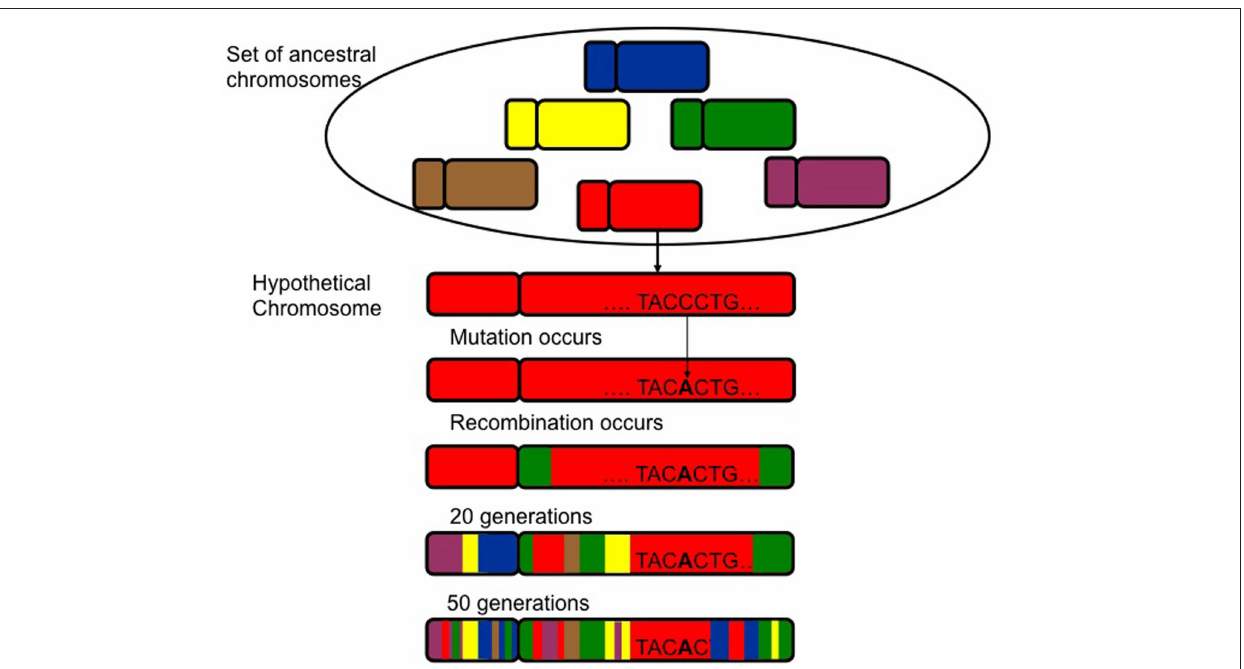
Figure 2 | The preservation of linkage disequilibrium (LD) through mutation and subsequent recombination in the human genome. At the time the mutation occurs it is in LD with the genetic background of the chromosome. Recombination changes the genetic background as variation is introduced until only the DNA sequence very near the mutation remains in